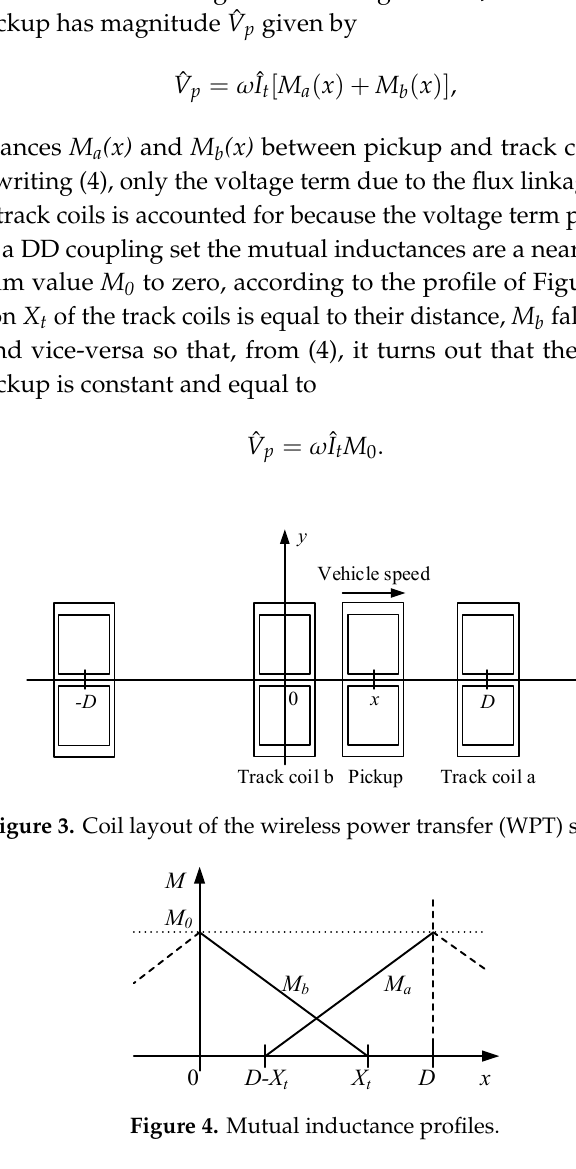
Figure 2. Double D (DD) coupling set.